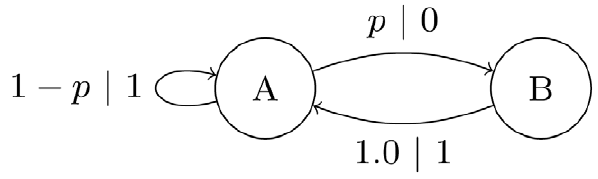
Figure 4. -Machine for the Golden Mean Process consisting of two causal states S ~ f A , B g that generates a population with no consecutive 0 s. In state the probabilities of generating a 0 or 1 are p and 1 { p , respectively.